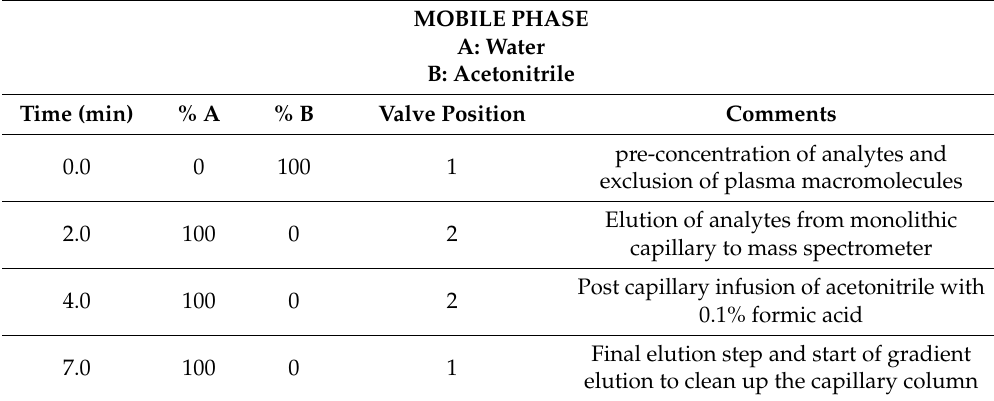
Table 3. In-tube SPME-MS/MS procedure.